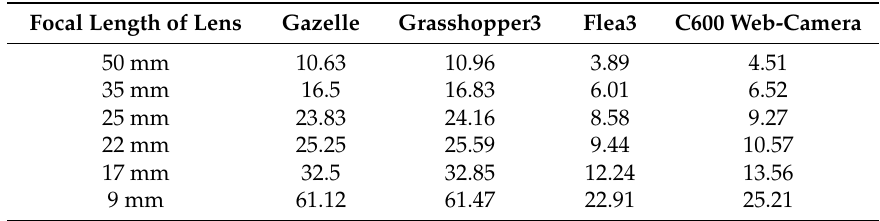
Table 4. The angles of camera view for each camera and lens (in ◦ ).